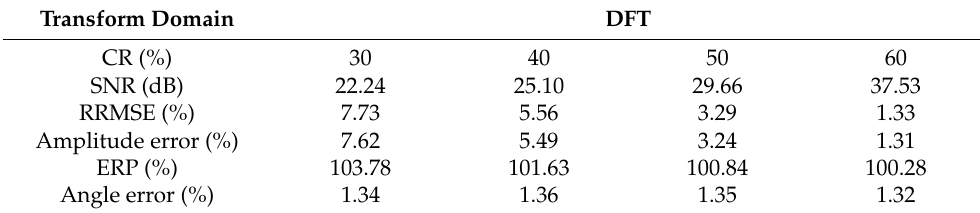
Figure 7. Measured original signal waveform and its DFT and DCT coefficients. Table 7. Reconstruction results of the harmonic signal in the DFT domain.